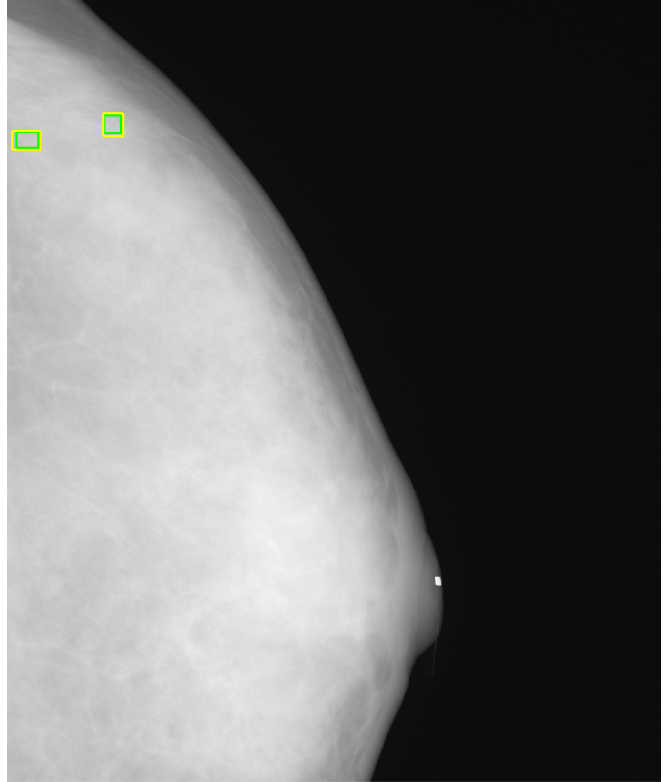
Figure 9. The automated MC cluster detection results.